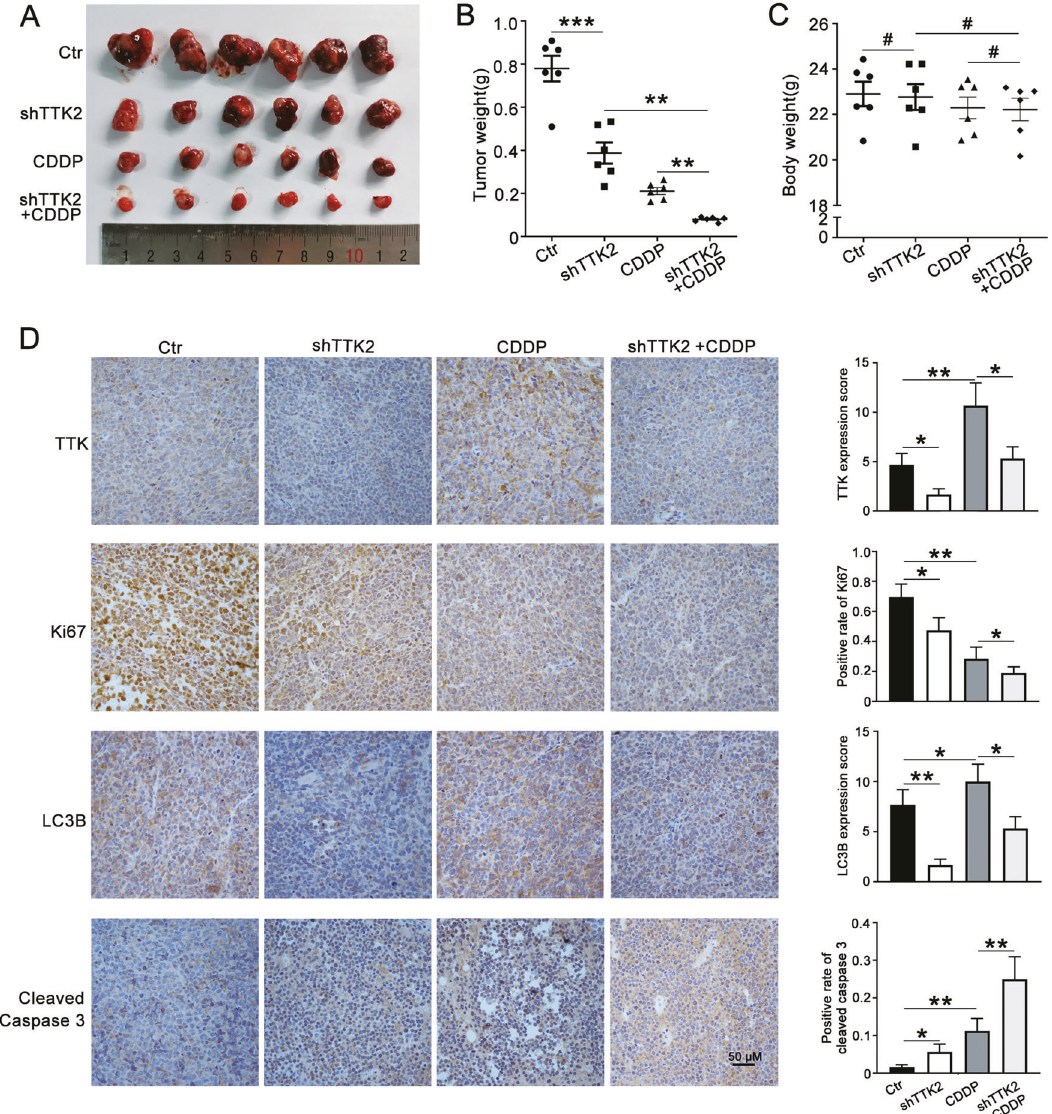
Fig. 8 Knockdown of TTK increases cisplatin sensitivity by inhibiting autophagy in vivo. CAOV3 cells transfected with shTTK2 or PLKO.1 were subcutaneously injected into the left armpit of each 5-week-old female mouse. When the tumor volumes were approximately 100 mm 3 , each group of mice was randomly divided into two subgroups and treated with or without CDDP (2 mg/kg) for 14 days. A Photographs of tumors from each group. B The tumor weights in each group. C The bodyweight of each group in ( A ). D Representative images of IHC